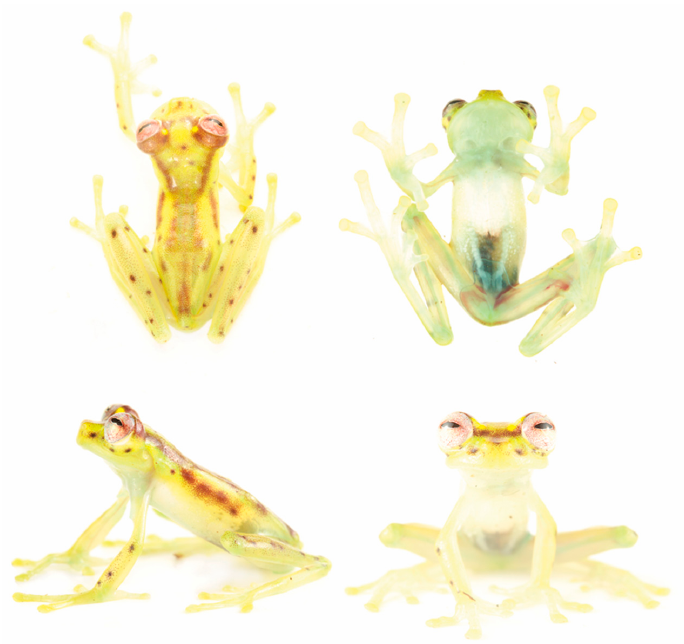
Figure 131. Nymphargus balionotus in life, ZSFQ 533. Ecuador, Reserva Río Manduriacu, 1254 m, Tungurahua province. Photos by Jose Vieira/Tropical Herping.